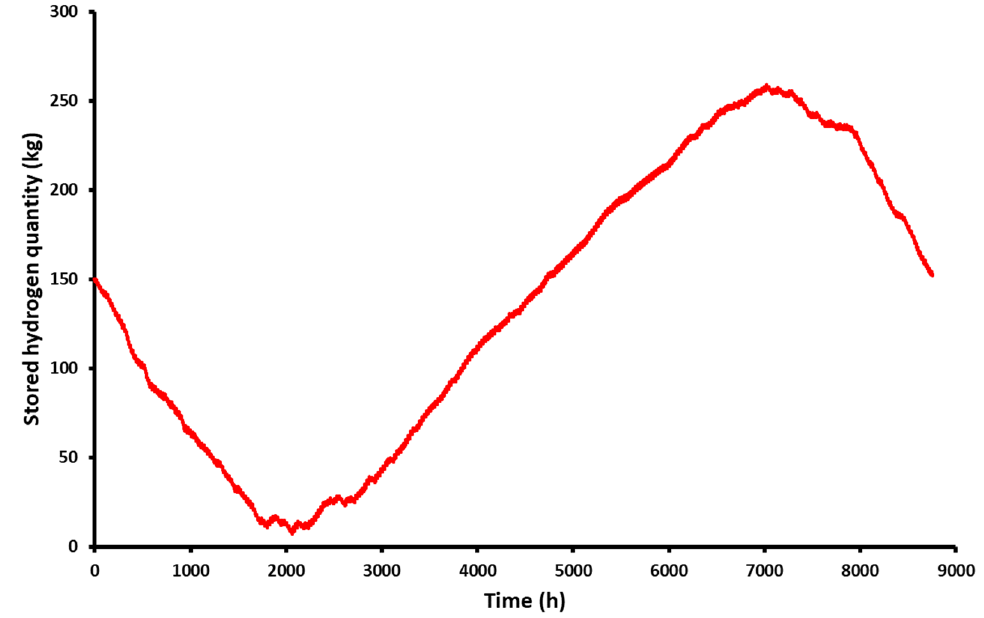
Figure 13. Variation in the stored hydrogen quantity during the year.